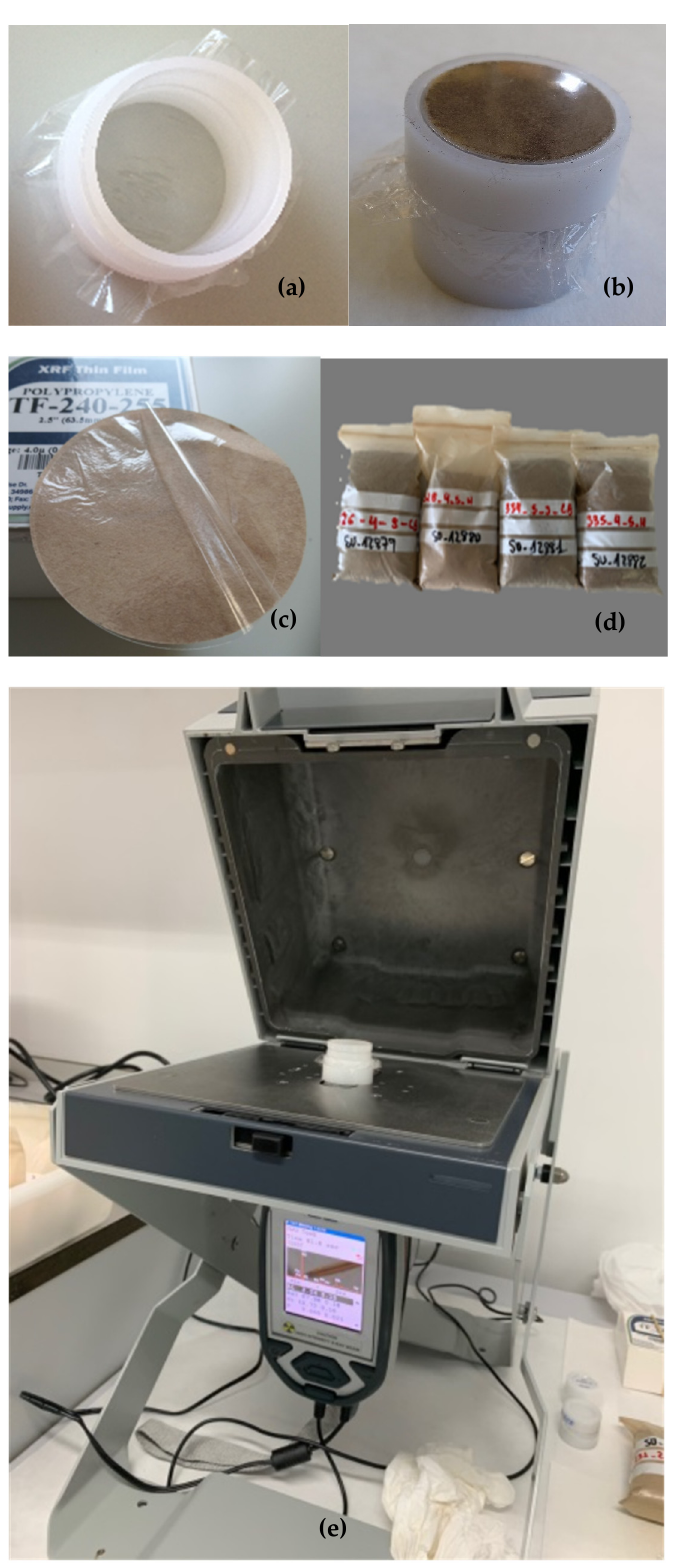
Figure 2. Performing measurements under laboratory conditions: ( a ) pXRF sample cup 25 mm high and 25 mm in diameter with protective film; ( b ) Sample cup filled with finely ground sample; ( c ) Thin protective film; ( d ) Samples in Ziploc bags; ( e ) Instrument attached to protection stand with sample positioned for measurement.